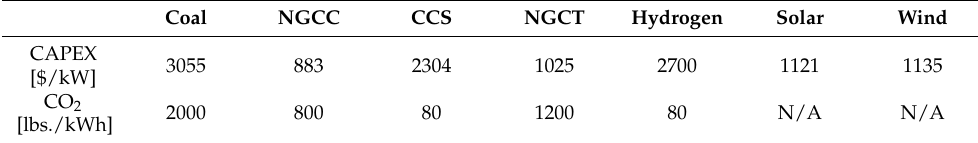
Table 3. Table of CAPEX construction cost and CO 2 emissions rates per generation